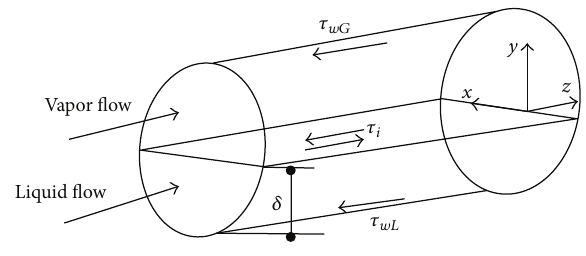
Figure 5: Shear stresses in